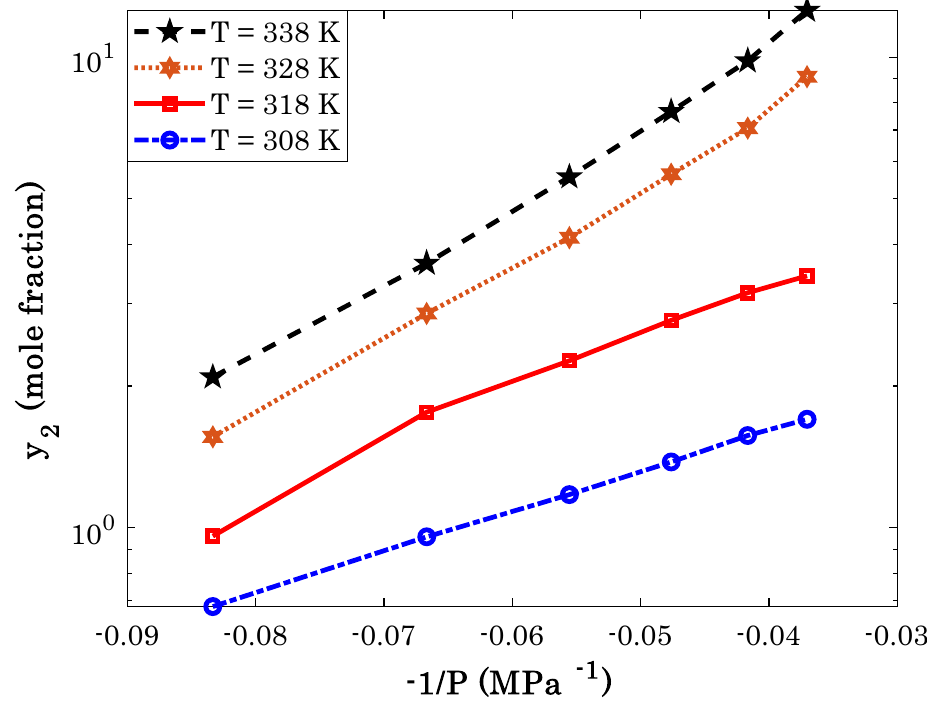
Figure 4. The effect of the inverse pressure on the sorafenib tosylate solubility in the SCCO 2 (the semi- logarithm